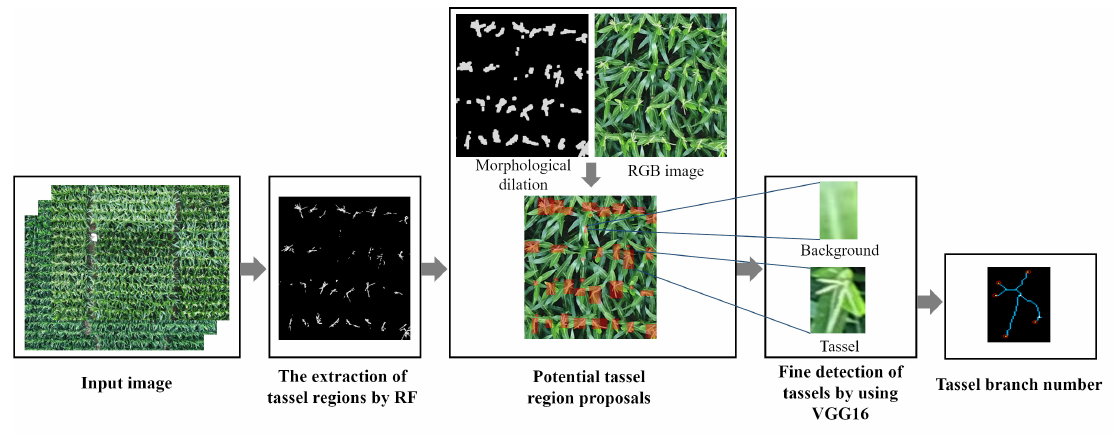
Figure 3. Schematic diagram of